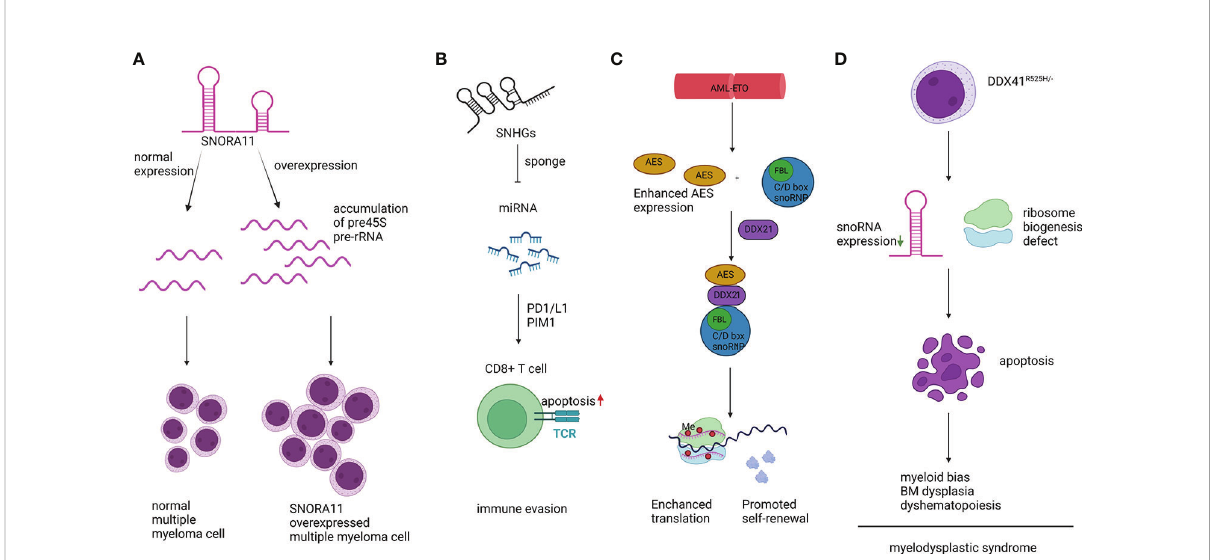
FIGURE 2 Representative mechanisms of snoRNAs in hematopoietic malignancies. (A). snoRNA ACA11 resulted in accumulated 45S pre-rRNA, promoted proliferation, and increased cell size. (B). SNHG sponged miRNAs and promoted myeloma cell immune evasion. (C). AML1-ETO protein promoted self-renewal of AML cells depending on the interaction between C/D box snoRNA and DDX21. (D). DDX41 R525H/- caused dysregulation in hematopoiesis, downregulation of snoRNA expression, and defects in ribosome